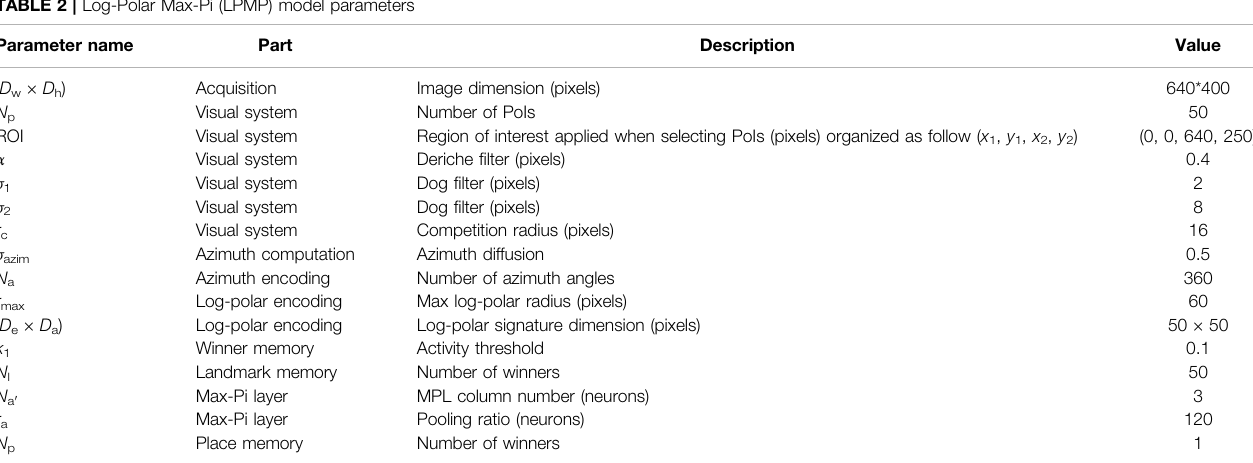
TABLE 2 | Log-Polar Max-Pi (LPMP) model parameters Parameter name